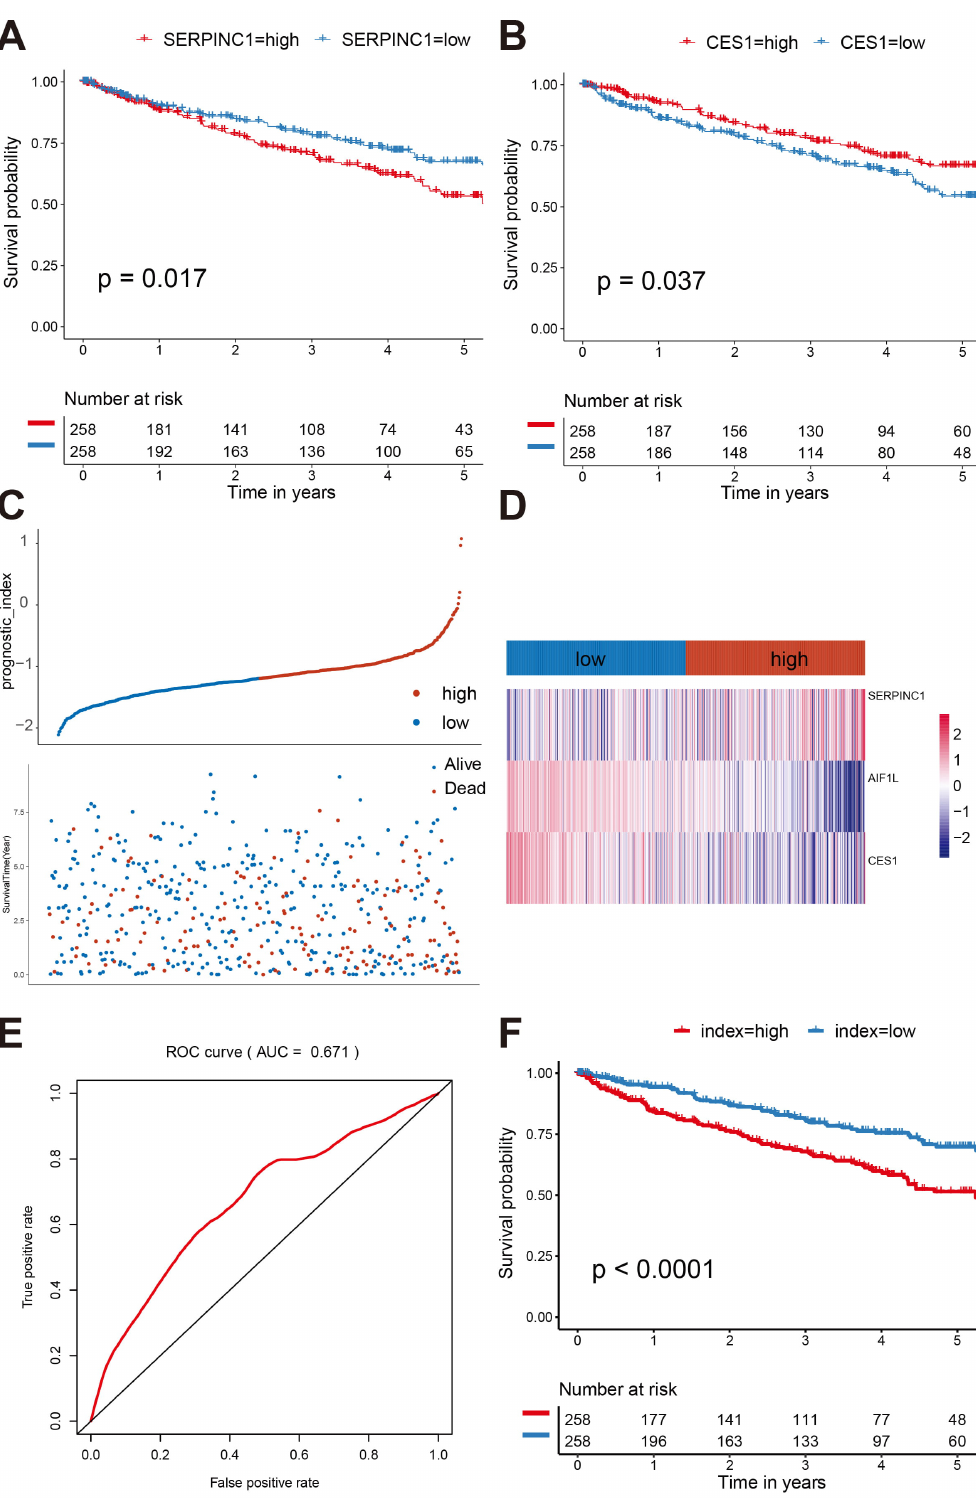
Fig. 3. Construction of a prognostic index model based on the expression level of three genes ( AIF1L , SERPINC1 , and CES1 ). (A–B) Kaplan-Meier survival plots for SERPINC1 and CES1 . High expression of SERPINC1 and low expression of CES1 indicated a poorer prognosis. (C) Detailed information on the low and high prognostic index groups in the TCGA dataset (upper); survival status and survival time for the TCGA ccRCC cohort (lower). (D) Heatmap for AIF1L , SERPINC1 , and CES1 expression in the TCGA dataset. (E) ROC curve estimating the performance of the prognostic index model for predicting first-year survival in the TCGA dataset. (F) Kaplan-Meier survival plots for high- and low-risk groups in the TCGA